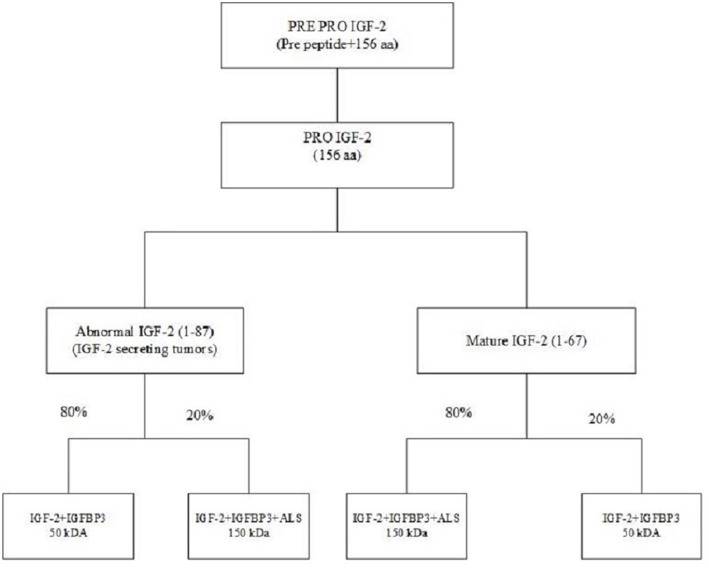
Synthesis and binding of mature and abnormal IGF-2.